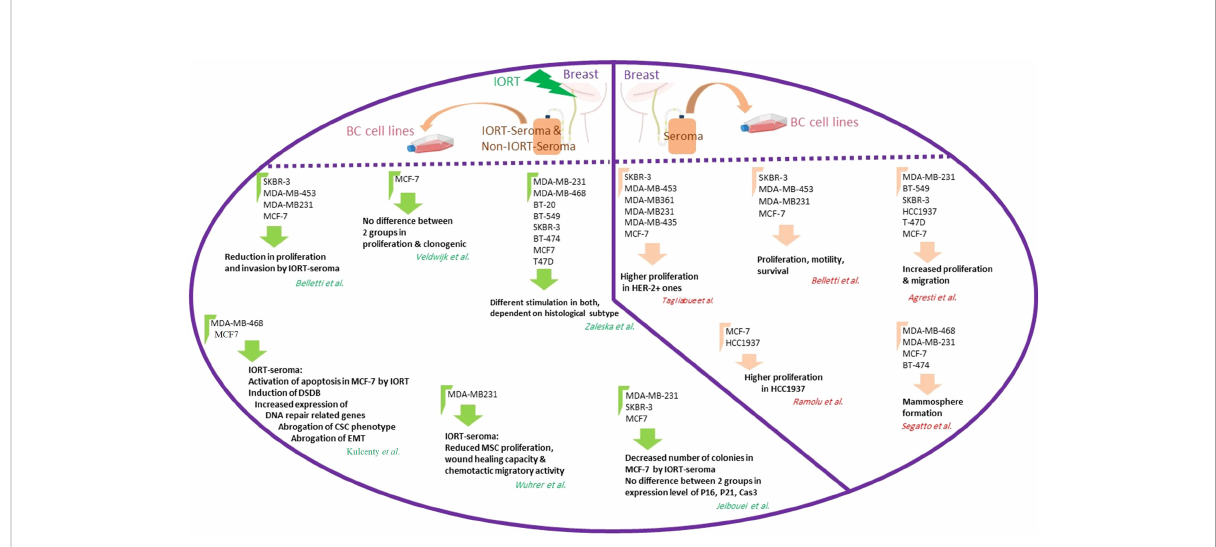
FIGURE 5 The studies related to the effects of seroma on BC cell lines. The right part of the circle shows the results from the effects of breast cancer seroma on breast cancer cell lines. The left part of the circle shows the results of the effects of IORT-treated and non-IORT-treated breast cancer seroma on breast cancer cell